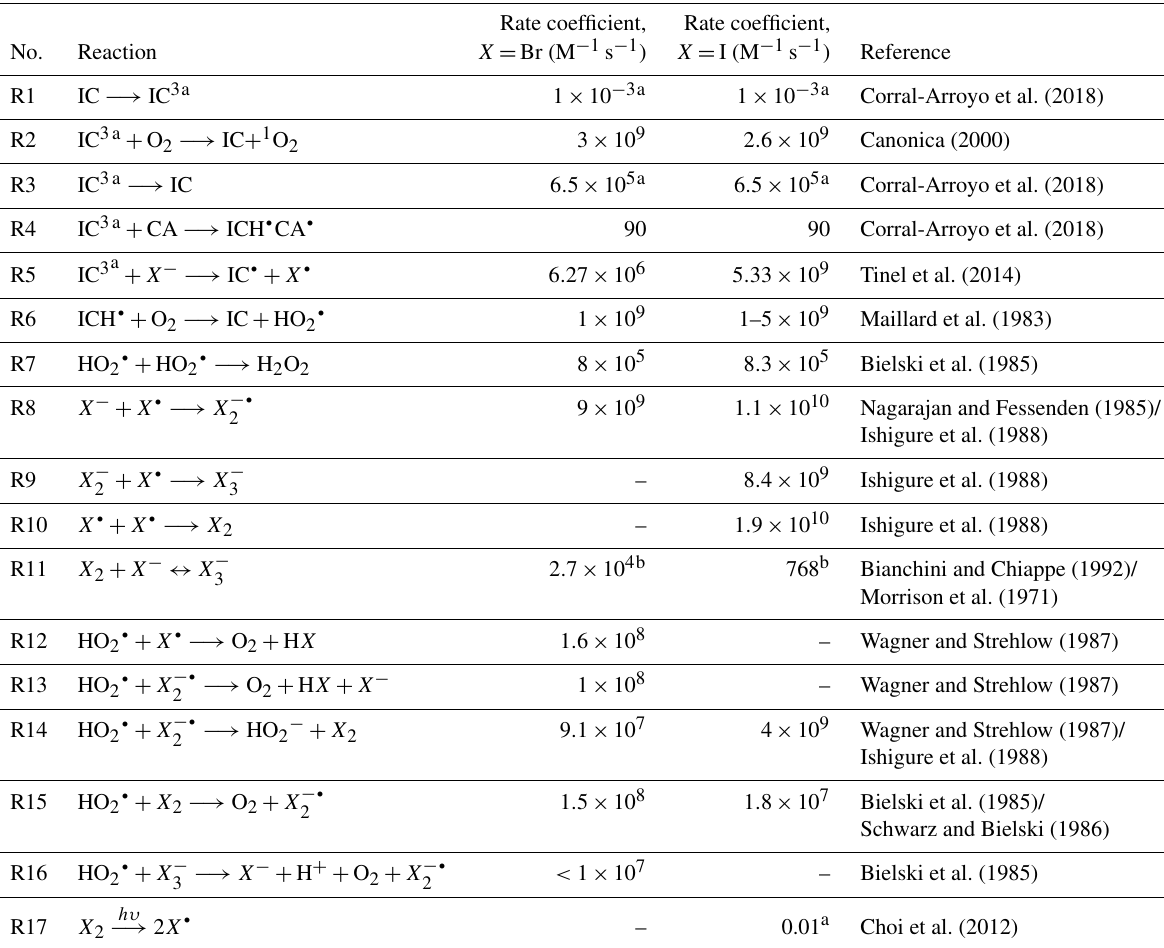
Table 1. Chemical reactions and the corresponding literature rate coefficients of halide and HO 2 radical chemistry. Rate